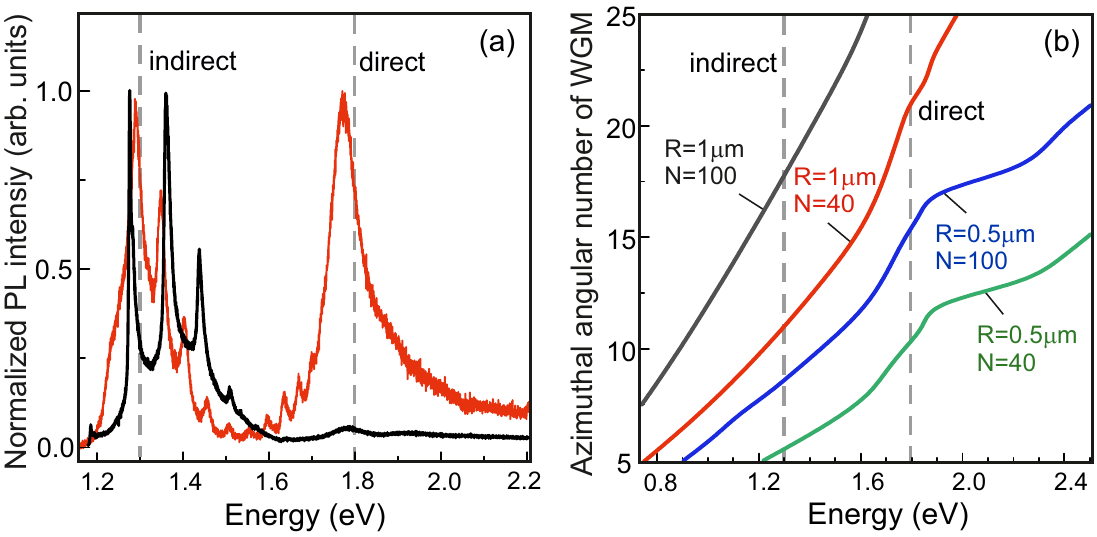
Figure 4. ( a ) TM-polarized micro-PL spectra measured in two different tubes of similar diameters ( ∼ 2 µ m) at 300 K. ( b ) Azimuthal angular numbers of whispering gallery modes (WGM) in NTs vs. energy calculated for different radii, R, and numbers of monolayers,